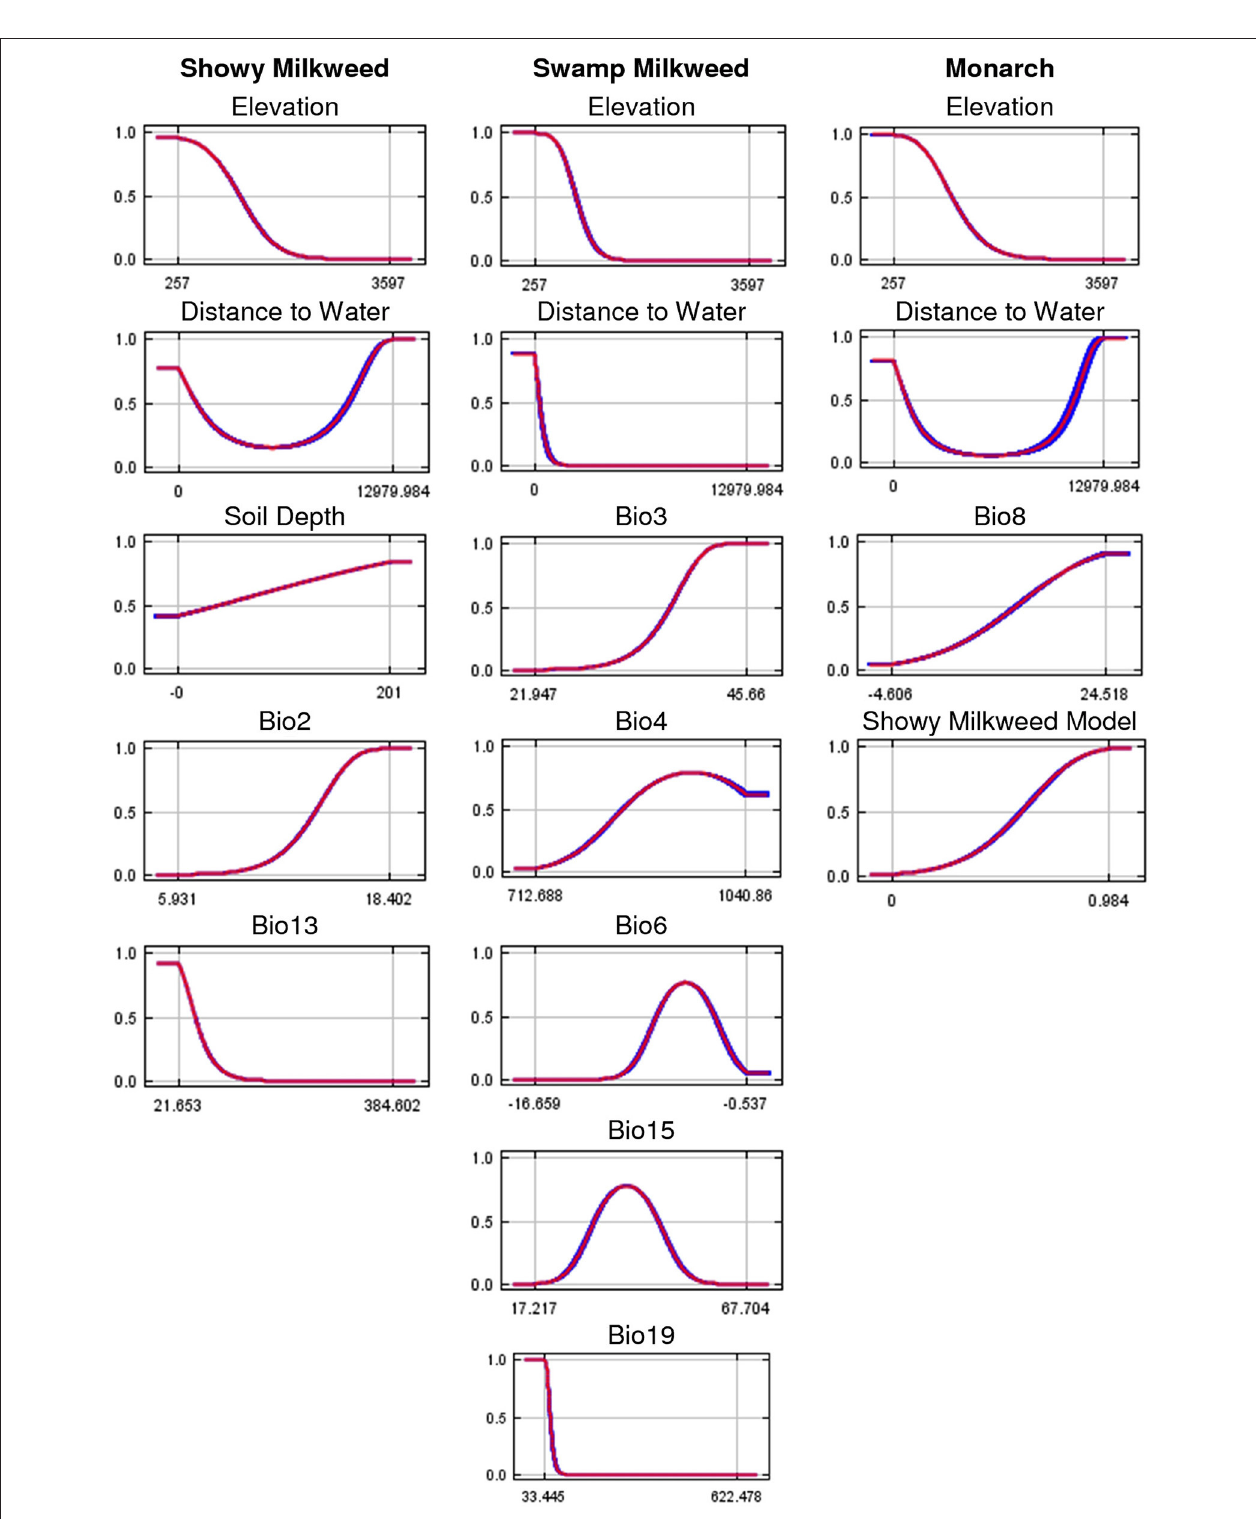
FIGURE 3 | Response curves for the most important variables in the final showy milkweed, swamp milkweed, and monarch predicted current distribution models. Curves represent a model created using only that variable, and reflect the dependence of predicted suitability on the selected variable and on correlations between the selected variable and other variables. The mean response of 10 replicate runs is in red and the mean ± 1 standard deviation is in blue. Y-axis values are predicted probability of suitable conditions, as given by cloglog output format. See Table 1 for variable abbreviations.